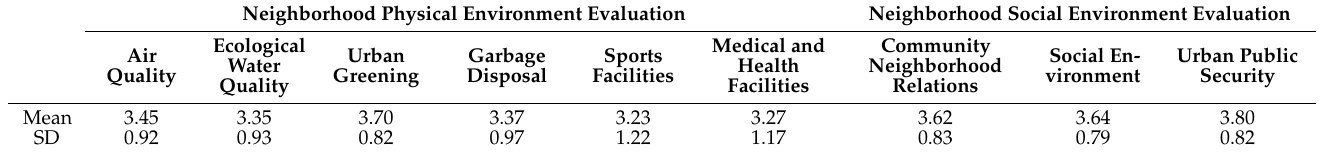
Table 2. Descriptive statistics of residents’ evaluation scoring